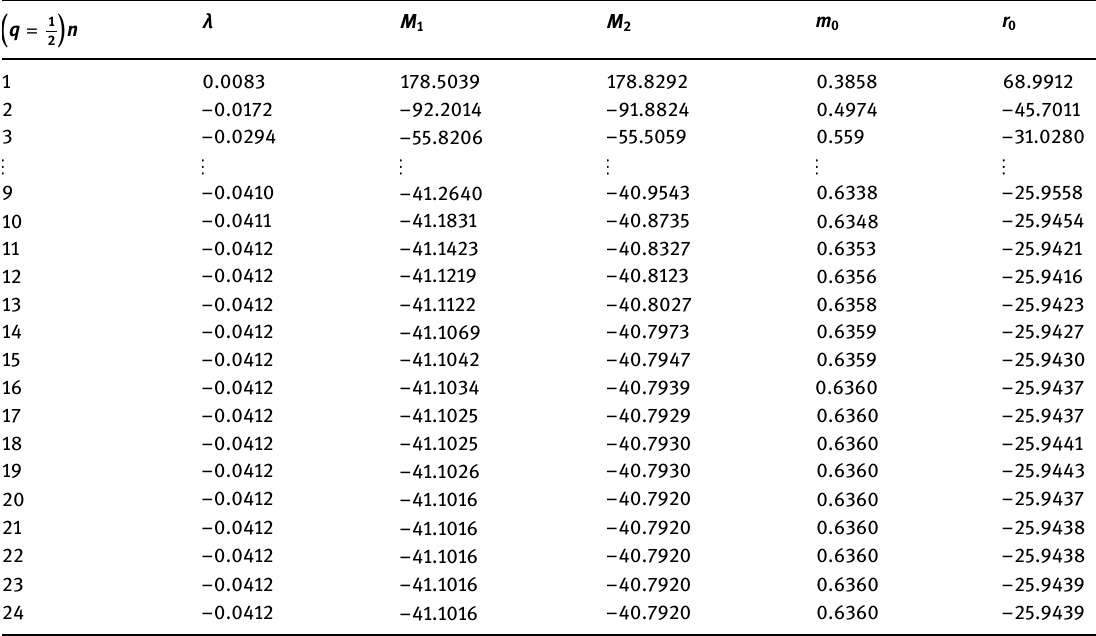
Table 2: Some numerical results of λ , M 1 , M 2 , m 0 , r 0 in Example 4.1 for ∈ t J and =